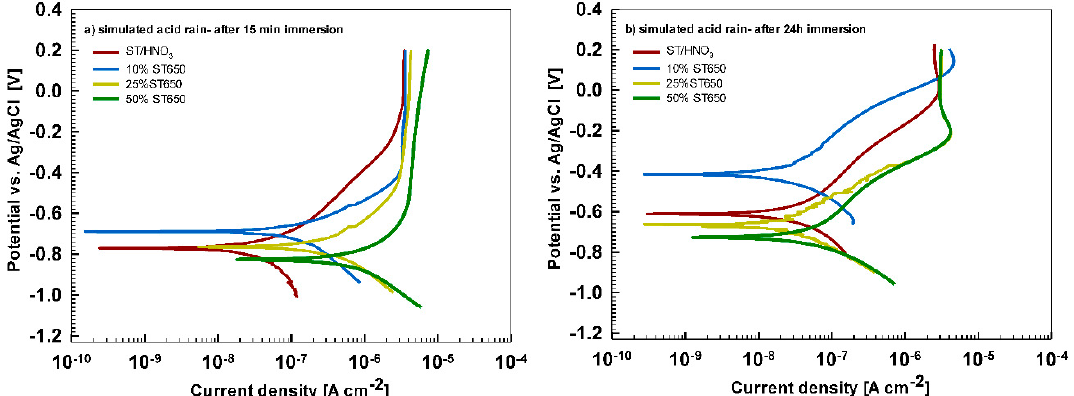
Figure 7. Potentiodynamic polarization curves recorded for uncoated, chemically pre-treated AA3003 (ST/HNO 3 ) and coated with ST650 coatings of different concentrations at a conversion time of 18 min at room temperature. The curves were recorded in simulated acid rain solution: ( a ) after 15 min immersion; ( b ) after 24 h immersion. The scan rate was 1 mV/s. Table 3. Electrochemical parameters deduced from potentiodynamic measurements in 3.5% NaCl and simulated acid rain solution for chemically pre-treated AA3003 (ST/HNO 3 ) coated with different concentrations of ST650. The polarization resistance ( R p ) was determined from linear the polarization measurements, and the corrosion potential ( E corr ), corrosion current density ( j corr ), breakdown potential ( E bd ) and Δ E = | E bd – E corr | from potentiodynamic polarization curves (Figures 6 and 7). Values are given as mean ± standard deviation.